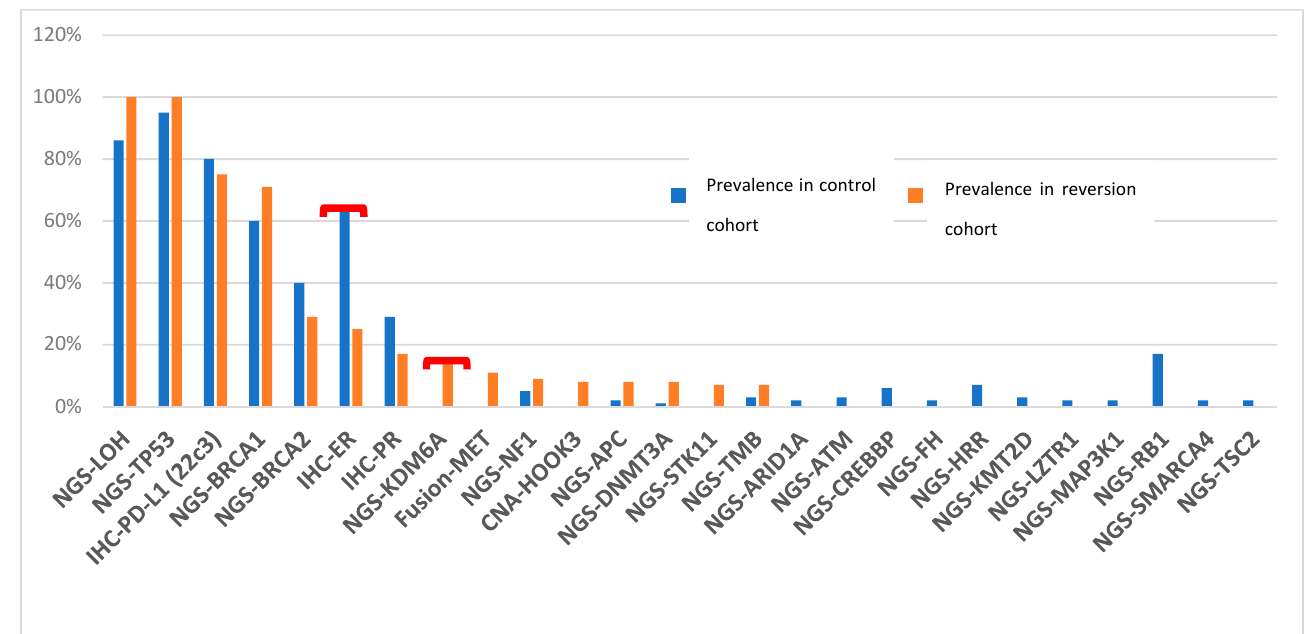
Figure 2. Comparing molecular profiling results of ovarian high-grade serous BRCA1/2 mutant tumors with or without reversions (Red brackets denote p < 0.05). The most prevalent altered biomarkers are shown.